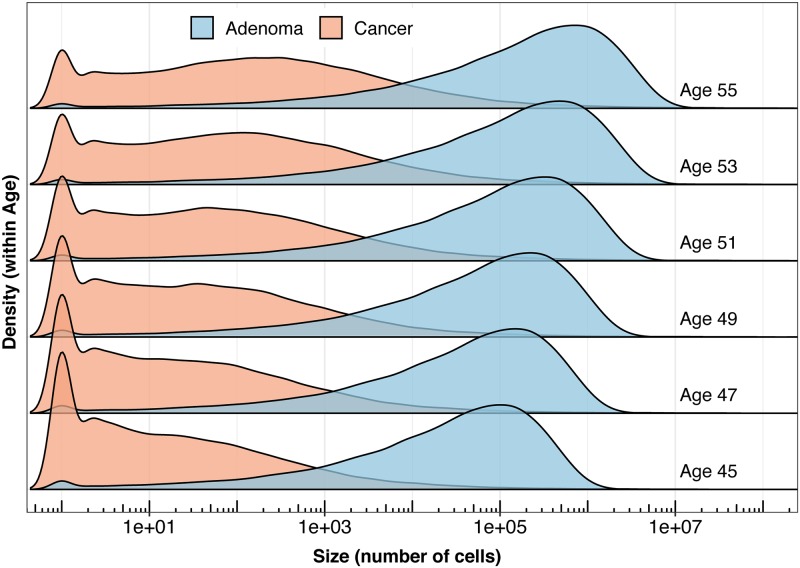
Illustration of simulated data for size of compartments A and M.We performed 100,000 simulations of the two stage branching process with biologically motivated parameters (μ1 = 3.1, b1 = 9, d1 = 8.8, μ2 = 10−5, b2 = 9.2, and d2 = 8.8). Presented are the empirical densities of compartments A and M, given non-extinction. Heights indicate the density of the size distribution at each given age.